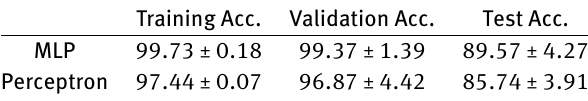
Table 2: Intention classification results. The numbers show the mean and standard deviation percentage.